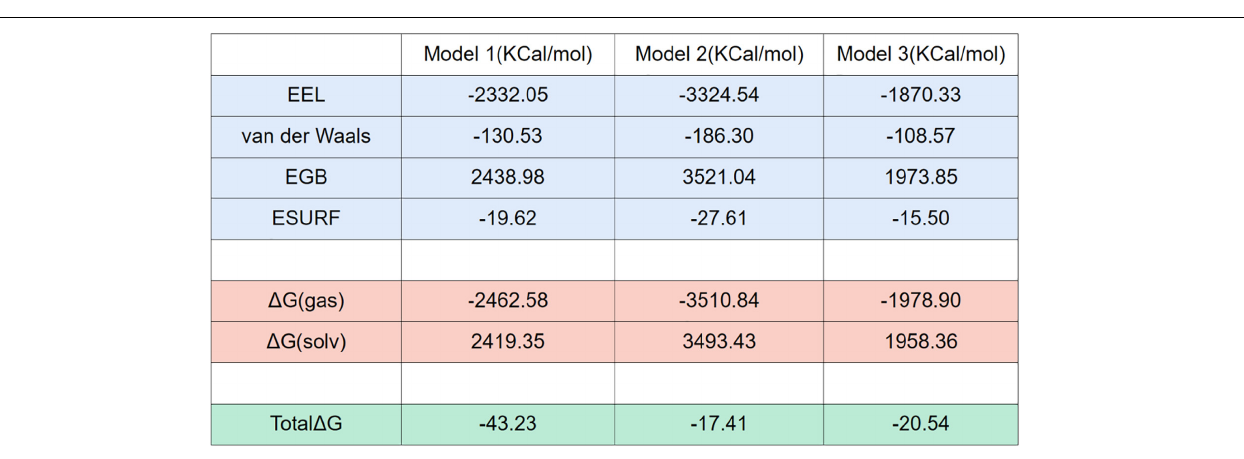
model was only based on the homologous structure of NLRP3 (NLRC4). In general, the conformational change reduces the steric hindrance on the side of NLRP3, which is conducive